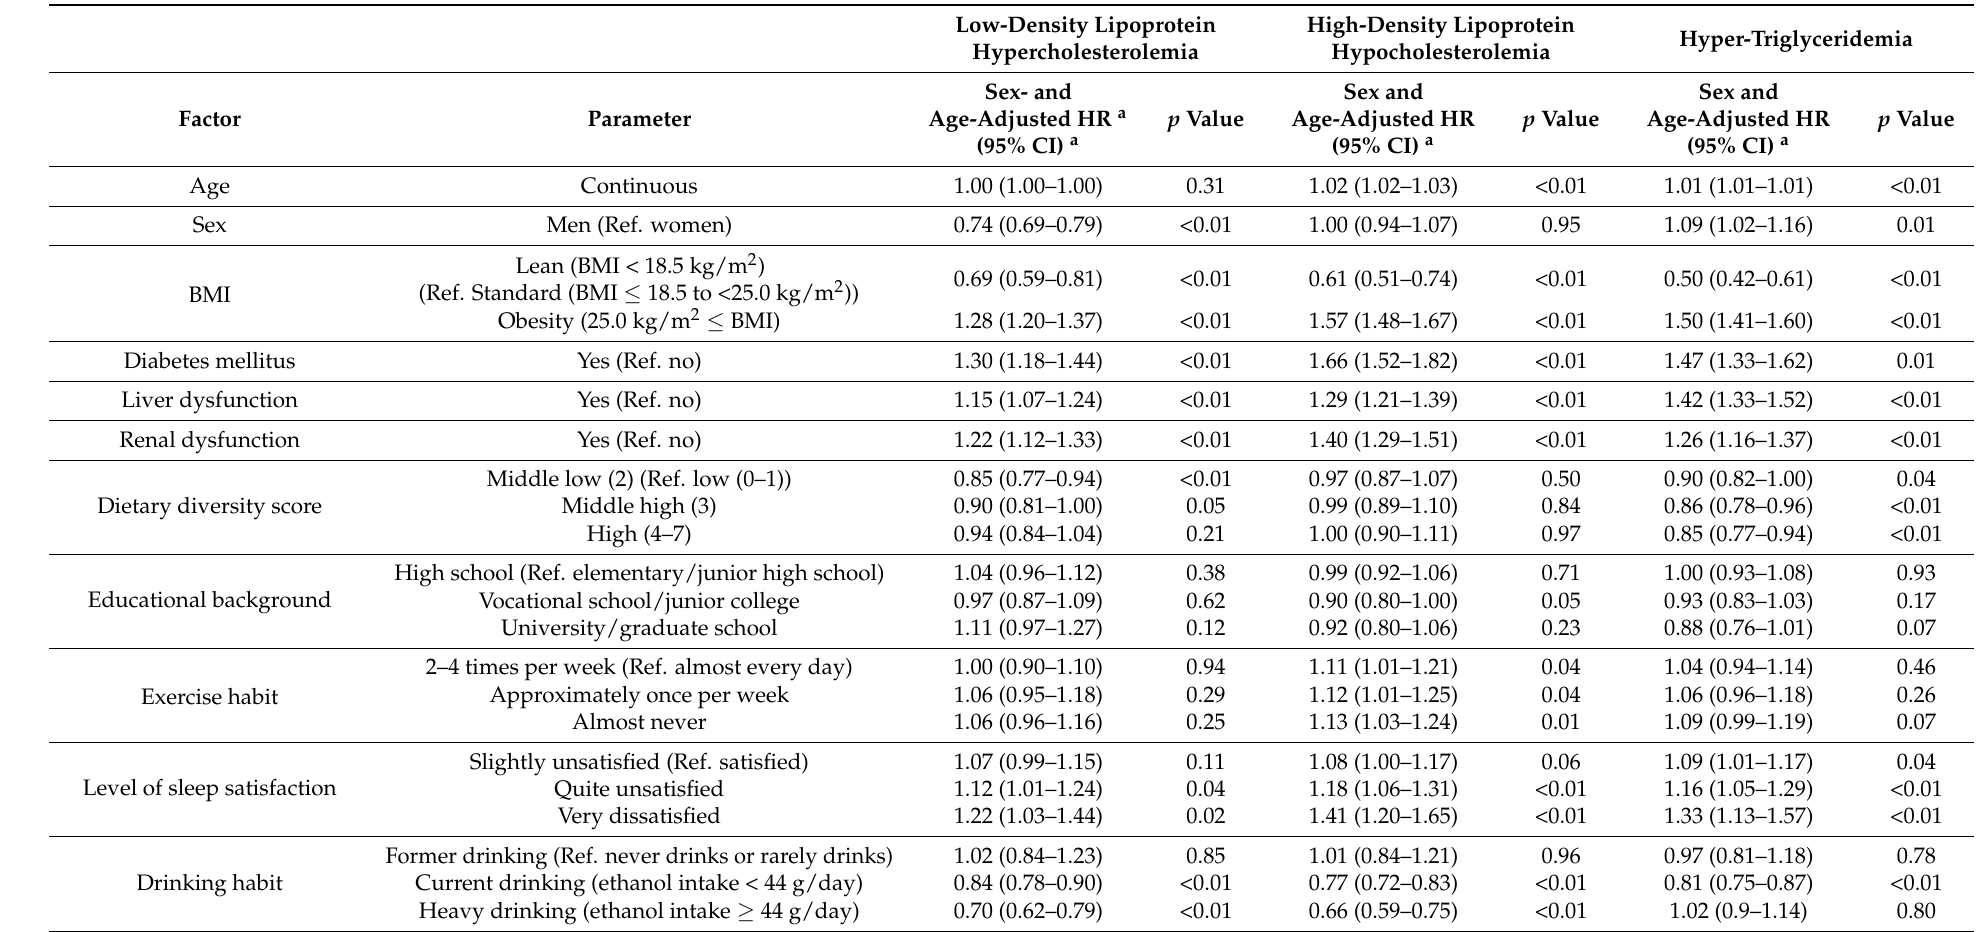
Table 3. Results of sex- and age-adjusted Cox regression